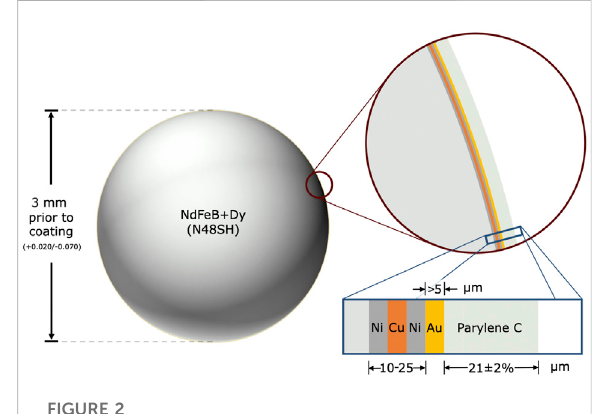
FIGURE 2 Spherical magnetic beads for implantation in muscle. The magnetic bead implants are composed of sintered neodymium- iron-boron (Nd: 26% – 33%, Fe: 63.2% – 68.5%, B: 1.0% – 1.2%, Dy- Tb: 0% – 1.5%, Nb: 0.3% – 1.4%, Al: 0.1% – 1.0%), with dysprosium and terbium added to increase the maximum working temperature to 150 ° C, which allows the implants to be autoclaved when needed. The base of each magnetic bead implant is approximately 3 mm in diameter (surface area ~0.283 cm 2 ) and has an approximate residual fl ux density of 1.36 – 1.42 T. The implant is coated in 10 – 25 μ m nickel-copper-nickel (see inset with blue border), with the outermost nickel coating being